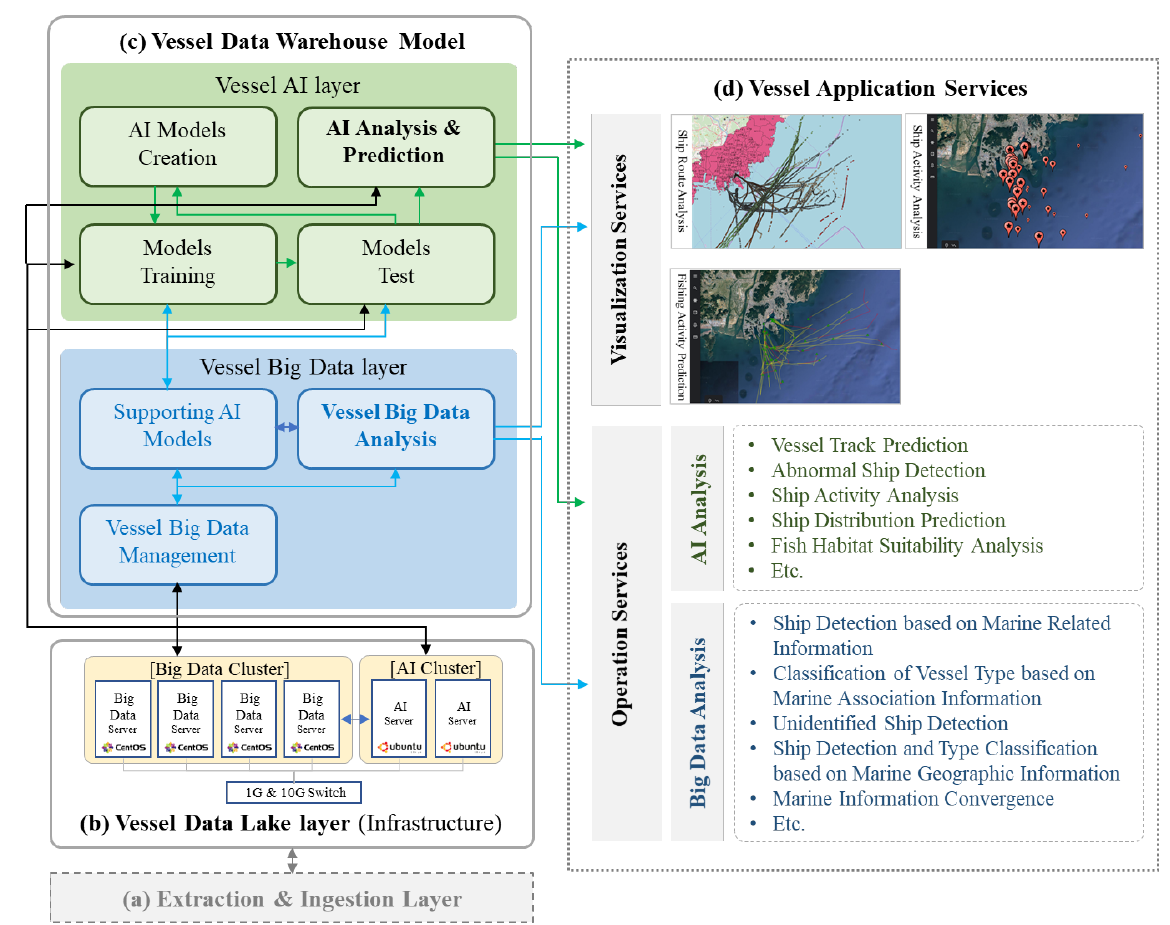
Figure 1. Conceptual Diagram of Vessel Data Lakehouse. ( a ) Extraction & Ingestion Layer; ( b ) Vessel Data Lake layer; ( c ) Vessel Data Warehouse Model; ( d ) Vessel Application Service.